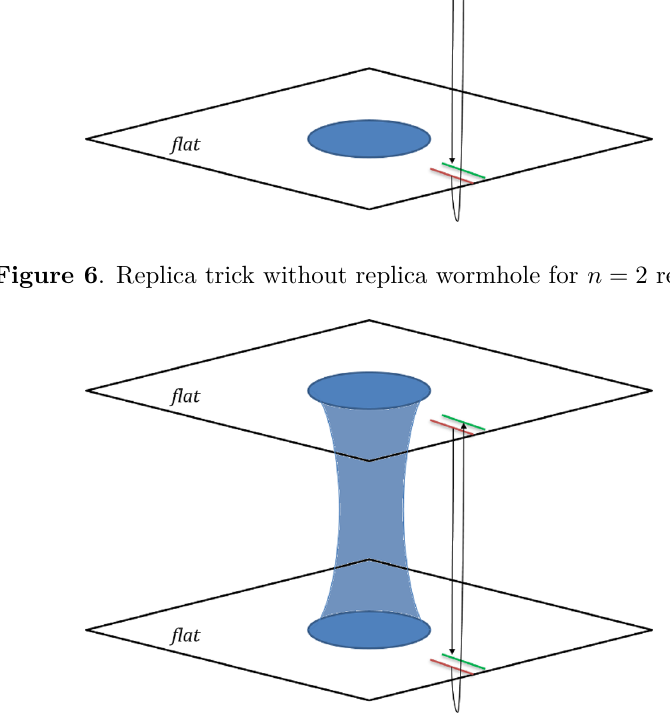
Figure 7 . Replica wormhole that connects gravity region of the two